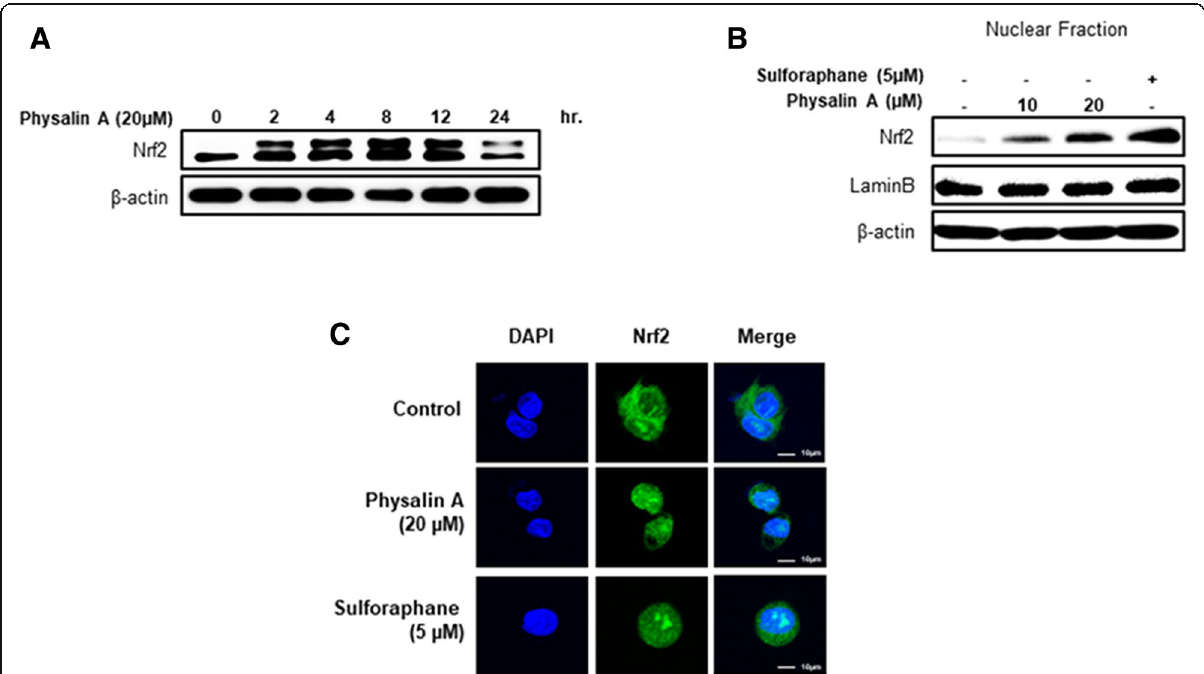
Fig. 5 Physalin A induces Nrf2 nuclear expression and activation. a Western blot analysis of Nrf2 expression in HepG2 cells. The cells were treated with 20 μ M physalin A for 0, 2, 4, 8, 12, 24h. b Western blot analysis of Nrf2 expression in the nuclear fraction. The cells were treated with 10 and 20 μ M physalin A for 4h. c Immunocytochemistry showing Nrf2 nuclear accumulation in HepG2 cells. The cells were treated with 20 μ M physalin A for